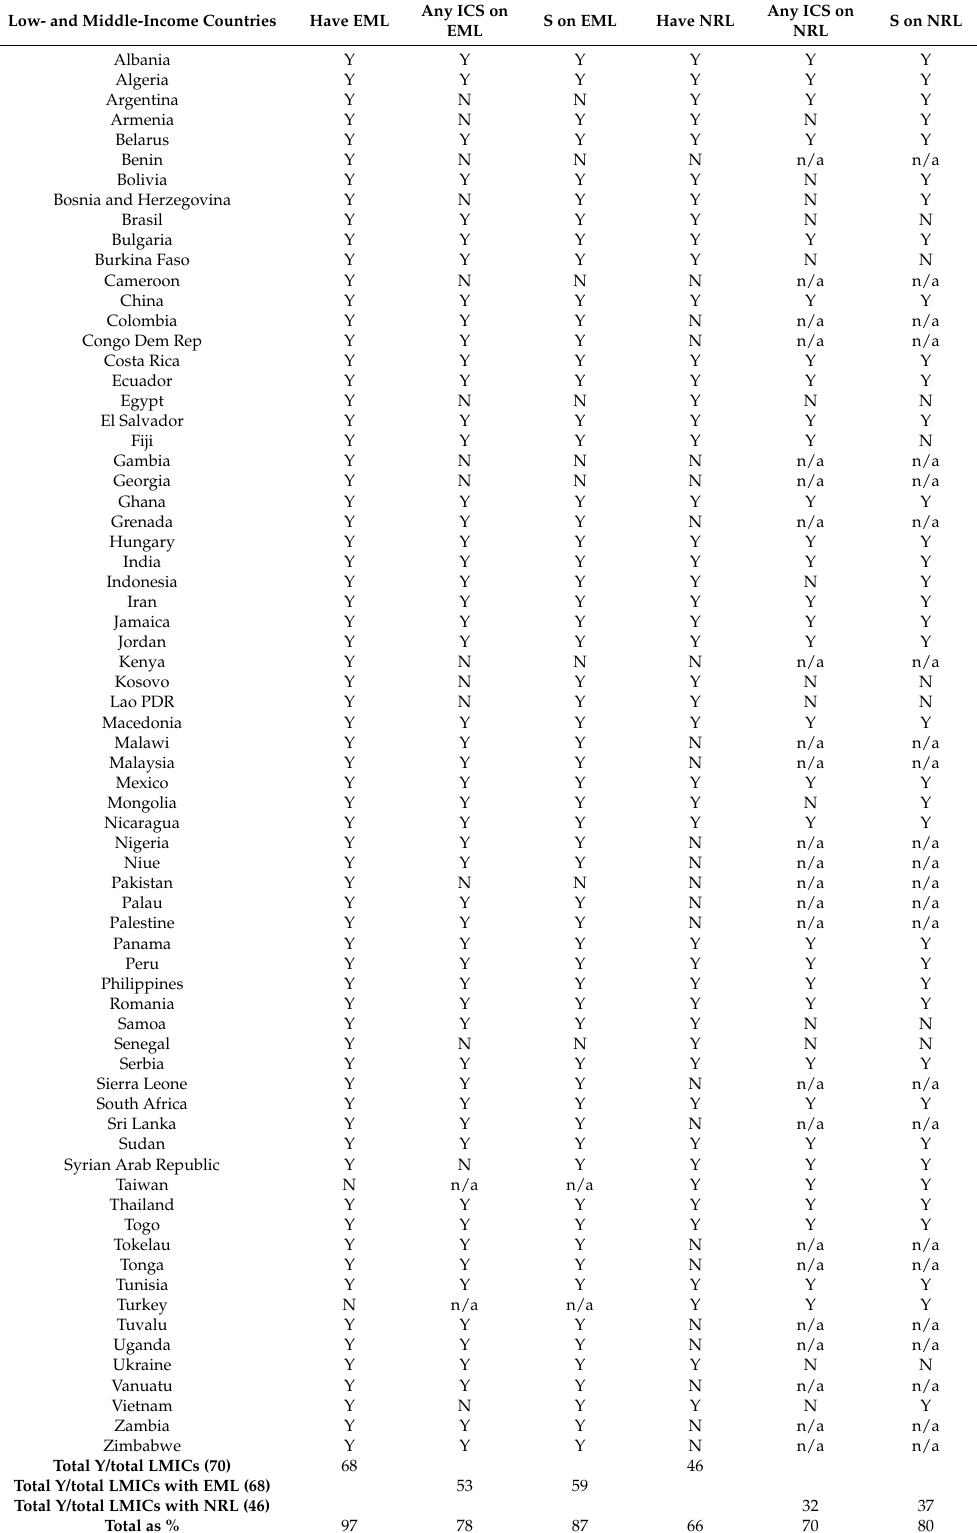
Table 2. Existence of National Medicine List and National Reimbursement List and inclusion of any inhaled corticosteroid and salbutamol, 70 low- and middle-income countries, 2014 *. Low- and Middle-Income